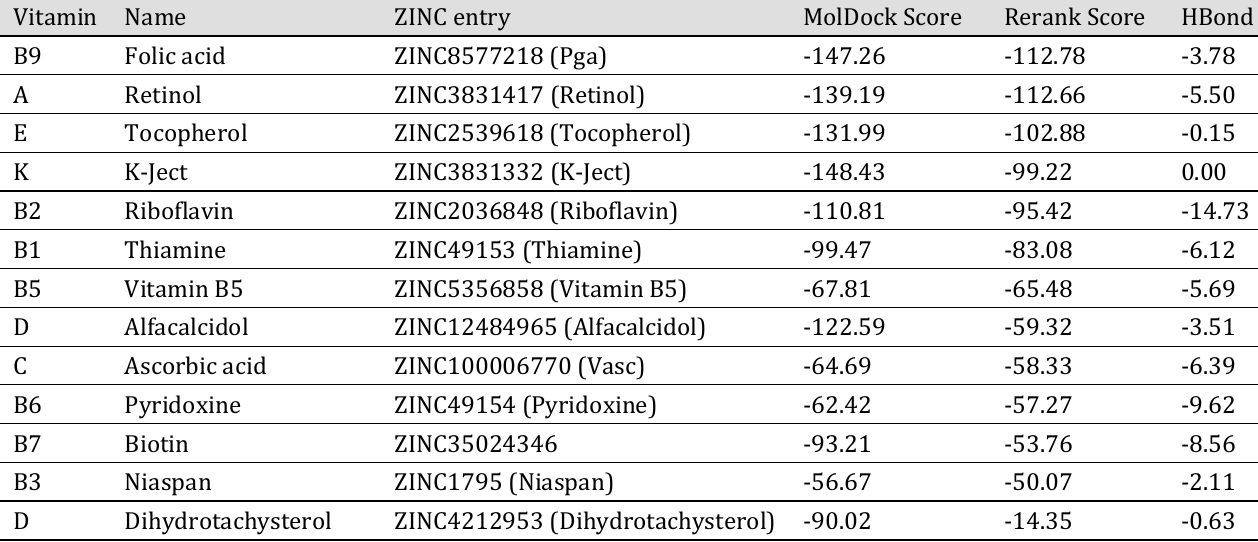
Table 3. The predicted poses scores of the inspected vitamins